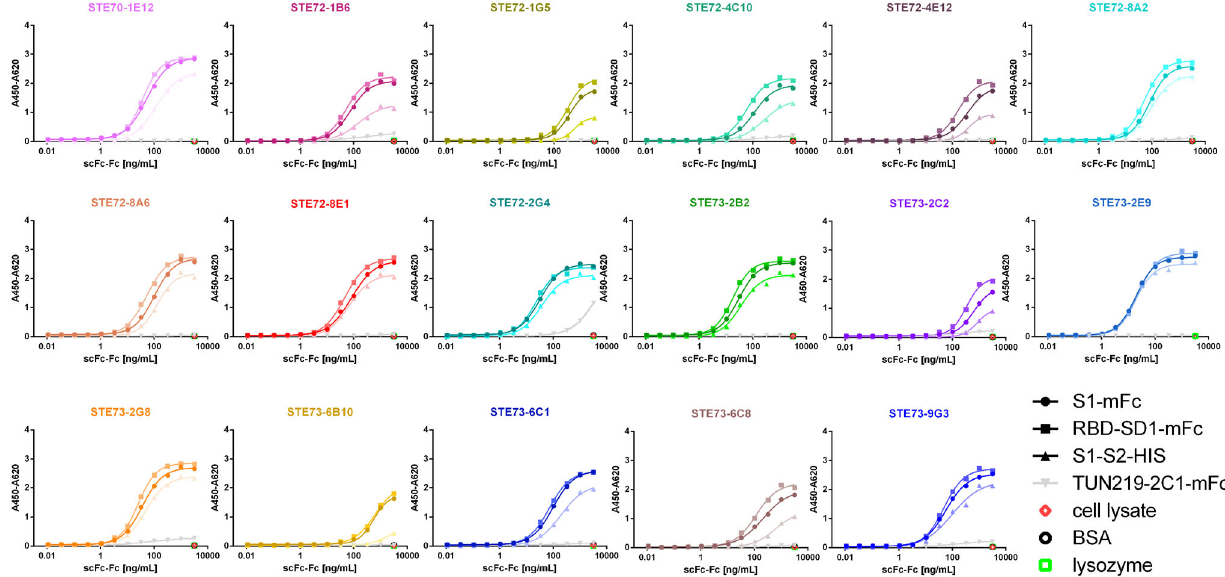
Fig. 3 Determination of EC50 on RBD. Binding in titration ELISA of the 17 best inhibiting scFv-Fc on RBD (fusion protein with murine Fc part), S1 (fusion protein with murine Fc part), or S1-S2 (fusion protein with His tag). Sequence SARS-CoV-2 (Gene bank QHD43416). An unrelated antibody with murine Fc part (TUN219-2C1), human HEK293 cell lysate, BSA, or lysozyme were used as controls. Experiments were performed in duplicate and mean values are given. EC50 were calculated with GraphPad Prism Version 6.1, fi tting to a four-parameter logistic